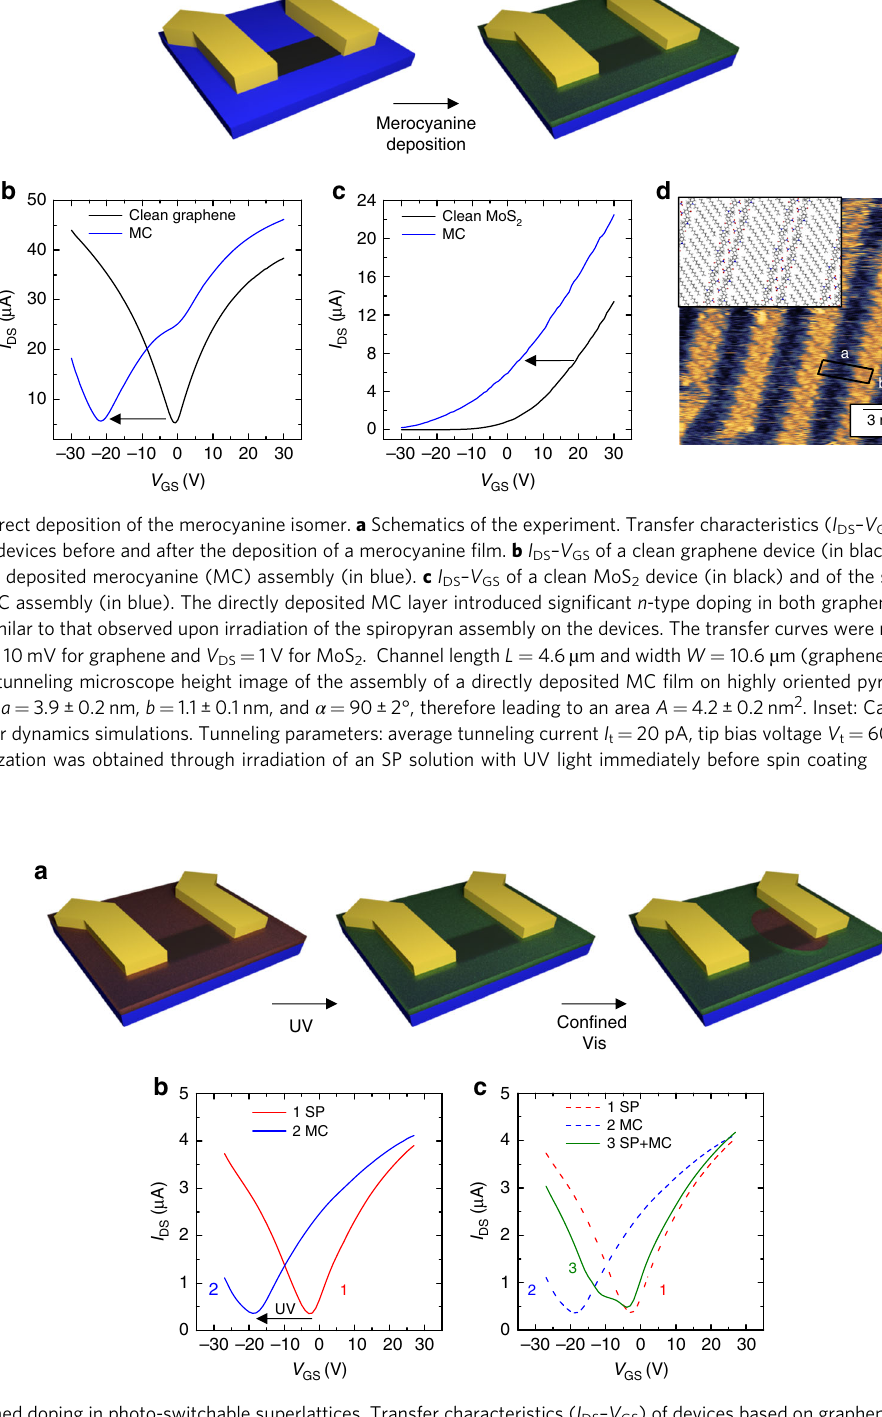
Fig. 5 Spatially con fi ned doping in photo-switchable superlattices. Transfer characteristics ( I DS – V GS ) of devices based on graphene and MoS 2 superlattices. I V I – V DS is the drain current, and GS is the gate potential. a Schematics of the experiment. DS GS characteristics are measured for: (1) The graphene device covered by the SP fi lm; (2) After UV light irradiation over the whole superlattice, which triggers the SP → MC isomerization; (3) After green light irradiation in a well-de fi ned area of the active layer, which triggers the MC → SP isomerization in the irradiated area. Gold contacts are schematically drawn in yellow, graphene in dark gray; the substrate in blue; the SP layer in semi-transparent red; the MC layer in semi-transparent green. b Trace 1 (red): graphene covered by the SP layer, trace 2 (blue): graphene/MC after UV irradiation over the whole fl ake. The arrow highlights the negative shift in the threshold voltage accompanying the SP → MC isomerization, indicative of n -type doping. c Trace 3 (green solid line): graphene/MC + SP, obtained by local irradiation with green light. Traces 1 and 2 are replotted. Details about the UV and green light irradiation are given in the Methods section; the transfer curves were measured applying a drain-source voltage V DS = 10 mV. Channel length L = 8.9 µ m and width W = 1.0 µ m